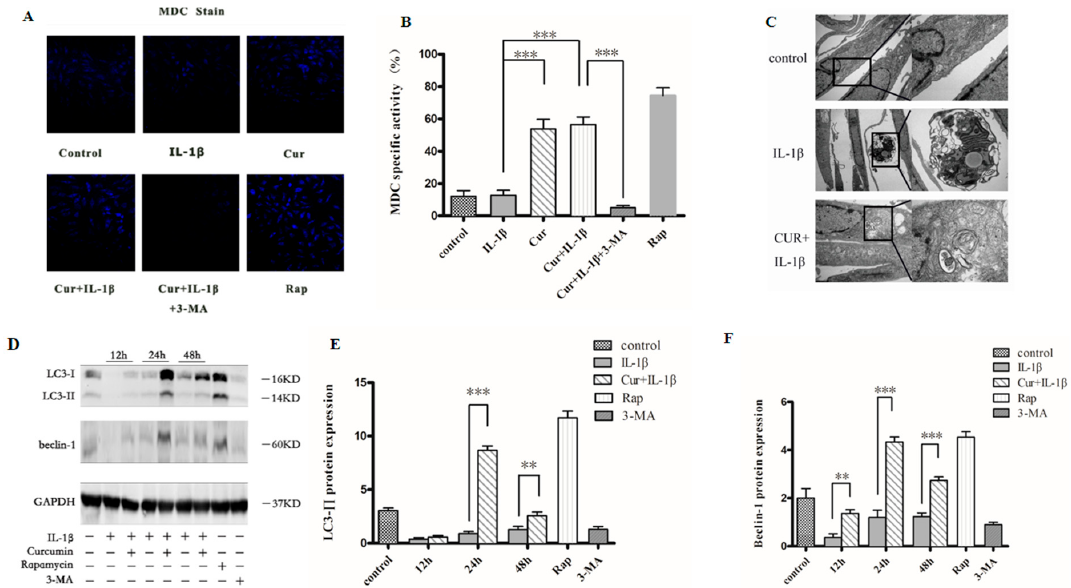
Figure 4. Curcumin activated autophagy within chondrocytes. The curcumin induced autophagy was detected by monodansylcadaverine (MDC) staining (( A ), quantified in ( B )) and transmission electron microscope (TEM) ( C ) at 24 h. Accumulation of autophagosomes was observed in chondrocytes that were pretreated with curcumin ( C ). Accumulation of beclin1 and light chain 3 (LC3)-II upon autophagy activation was visualized by western blot (( D ), quantified in ( E ) and ( F )). Results in ( B , E , F ) are expressed as means ± SD for experiments performed in triplicate. * p < 0.05, ** p < 0.01, and *** p < 0.001. Cur, curcumin; Rap, rapamycin; 3-MA, 3-Methyladenine.